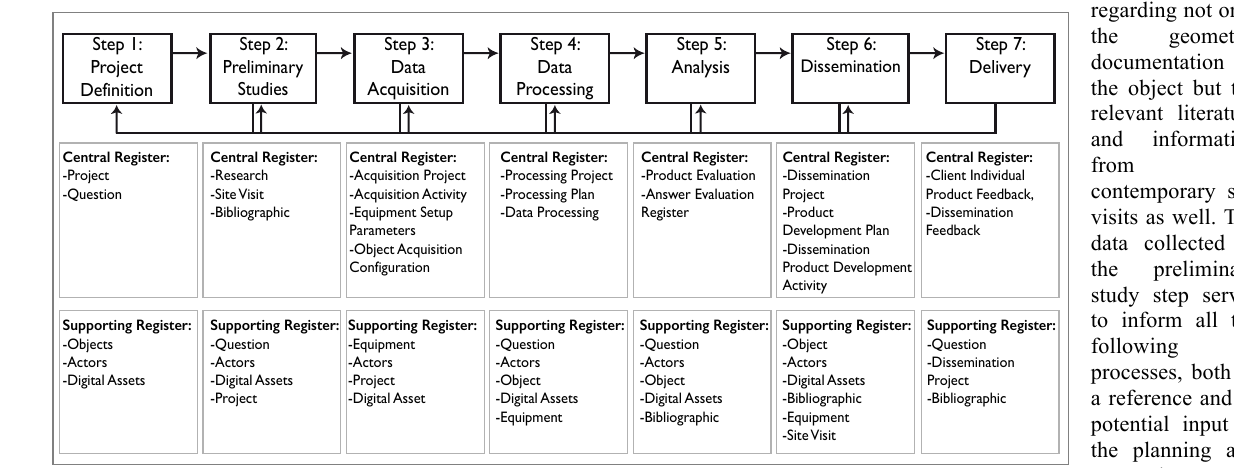
Figure 1. Overview of the general documentation pipeline and its related